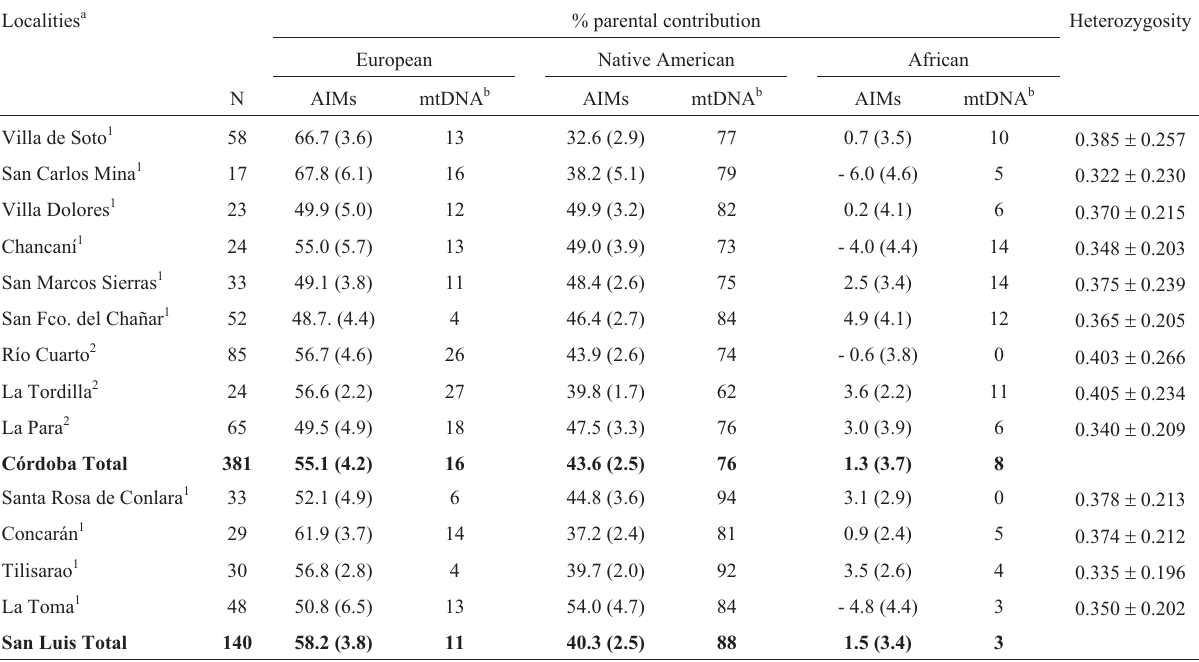
Table 3 - Percentage of continental parental contribution for autosomal AIMs (SD, Standard Deviation) and mitochondrial haplogroups, and heterozygosity values for 13 villages of central Argentina. Localities a